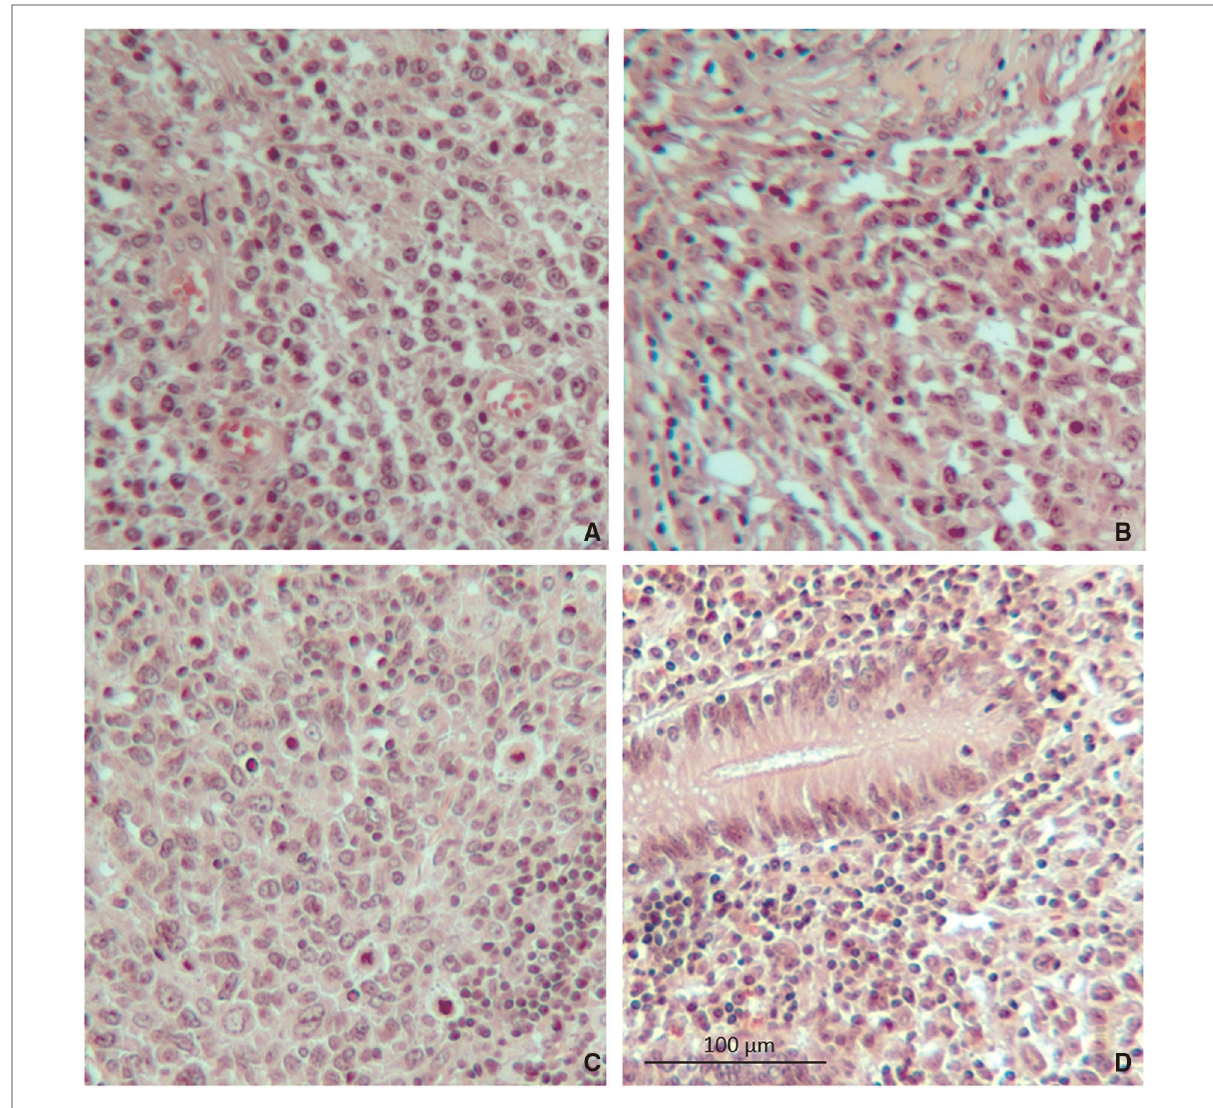
FIGURE 3 Microscopic specimen of the spleen and colon. ( A ) Atypical lymphoma cells were found in the spleen on hematoxylin – eosin stain. ( B ) Evidence of capsular invasion by lymphoma cells. ( C ) Splenic hilum lymph node containing lymphoma cells. ( D ) Lymphoma cells found in the colon wall near the splenocolic fi stula (10× magni fi